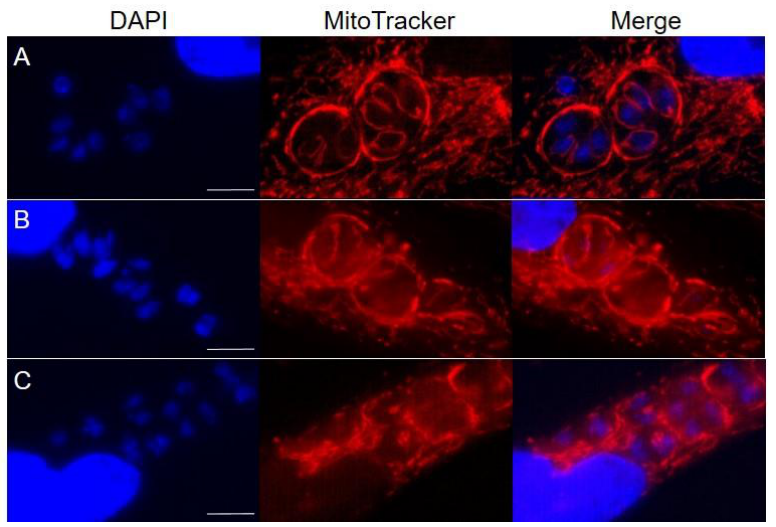
Figure 2. Mitochondrial membrane potential and morphology were disrupted in the presence of the BPZ derivatives. Intracellular parasites were grown in the presence of ( A ) Dimethyl sulfoxide (DMSO) ( B ) bisphenol Z (BPZ) (50 µM), or ( C ) isopropyl-BPZ (50 µM) for 4 h prior to MitoTracker staining, fixation, and imaging. Scale bars represent 5 µm.